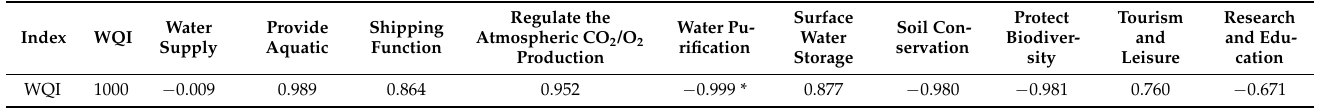
Table 14. Pearson correlation between Water Environment Qualities Index (WQI) and water ecosystem service value